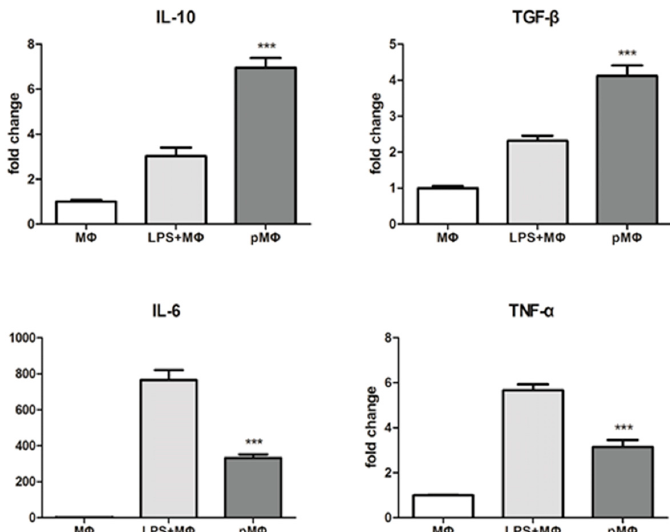
Figure 2. Inflammatory factors secreted by the cell of M Φ , LPS + M Φ , and pM Φ . Anti-Inflammatory factors interleukin-10 (IL-10) and transforming growth factor- β (TGF- β ) had higher expression in pM Φ , and pro-Inflammatory factors IL-6 and tumor necrosis factor- α (TNF- α ) had lower expression in pM Φ . *** p < 0.001 compared with M Φ . Each bar represents the mean value ± SD of triplicate results, which means three independent experiments were done.